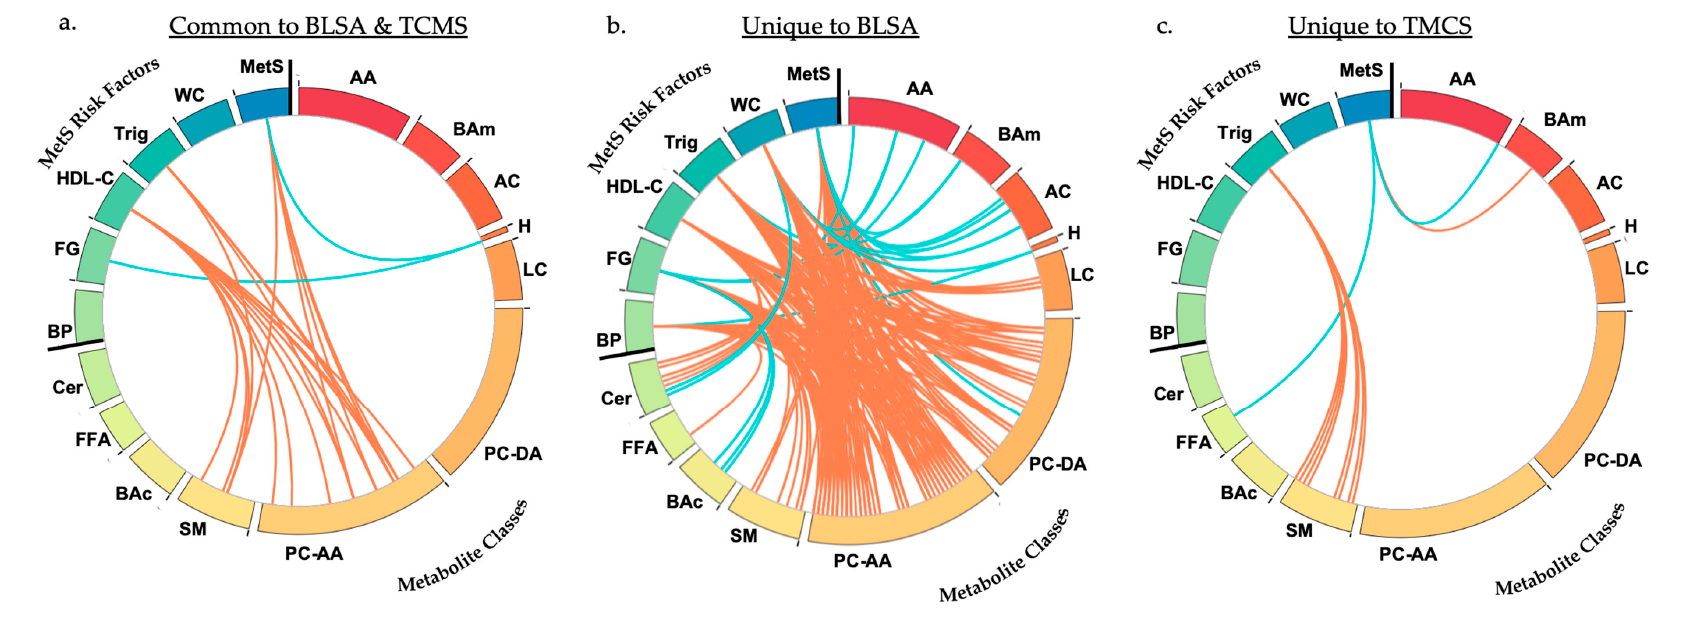
Figure 2. ( a ) Circos plot of overlapping significant associations in BLSA and TMCS; ( b ) Circos plot of significant associations unique to BLSA; ( c ) Circos plot of significant associations unique to TMCS. Outcomes, including MetS and individual risk factors, and metabolite classes are presented in bold and separated by black bold lines. Each color represents a different risk factor or metabolite class. BLSA: Baltimore Longitudinal Study of Aging; TMCS: Tsuruoka Metabolomics Cohort Study; AA: amino acids; BAm: biogenic amines; AC: acylcarnitines; H: hexoses; LC: lysophosphatidylcholines; PC-DA: phosphatidylcholines-diacyl; PC-AA: phosphatidylcholines-acyl-alkyl; SM: sphingomyelins; BAc: bile acids; FFA: free fatty acids; Cer: ceramides; BP: blood pressure; FG: fasting glucose; HDL-C: high-density lipoprotein cholesterol; Trig: triglycerides; WC: waist circumference; MetS: metabolic syndrome. Orange lines represent odds ratio < 1 at 0.05 FDR-adjusted significance level indicating that higher concentration of the metabolite is associated with a lower odds of the outcome. Turquoise lines represent odds ratio > 1 at 0.05 FDR-adjusted significance level indicating that higher concentration of the metabolite is associated with higher odds of the outcome.